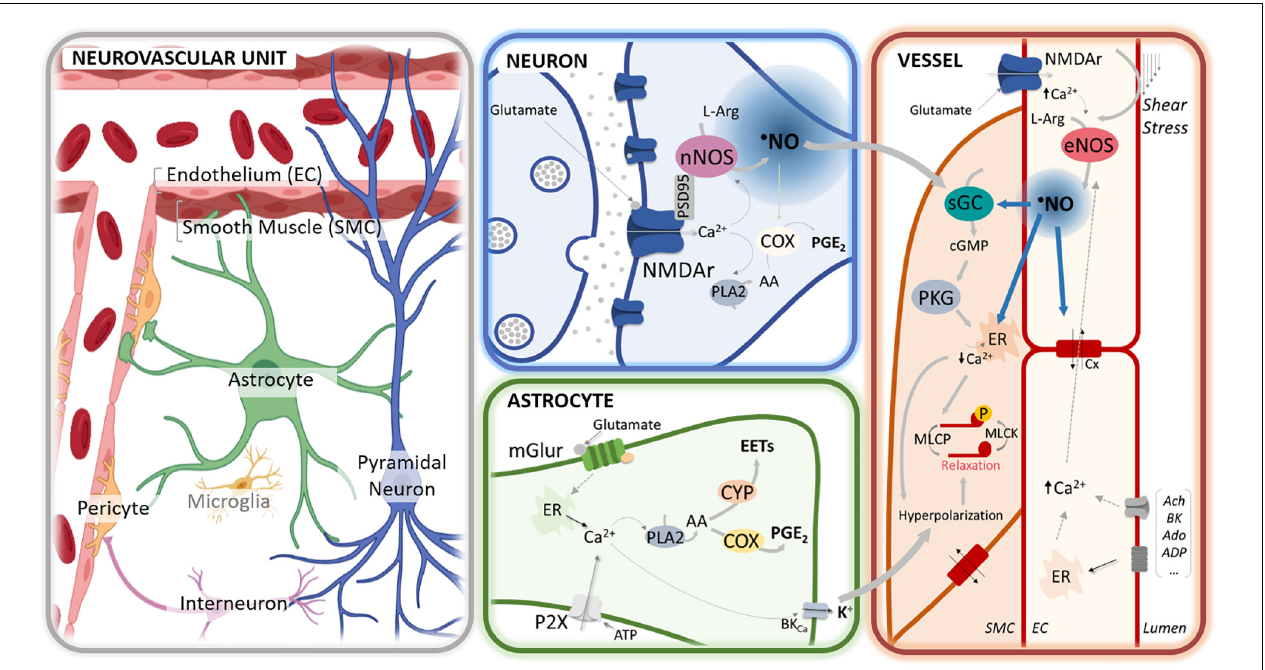
FIGURE 1 | • NO-mediated regulation of neurovascular coupling at different cellular compartments of the neurovascular unit. In neurons, glutamate release activates the N -methyl- D -aspartate (NMDA) receptors (NMDAr), leading to an influx of calcium cation (Ca 2 + ) that activates the neuronal nitric oxide synthase (nNOS), physically anchored to the receptor via the scaffold protein PSD95. The influx of Ca 2 + may further activate phospholipase A 2 (PLA 2 ), leading to the synthesis of prostaglandins (PGE) via cyclooxygenase (COX) activation. In astrocytes, the activation of mGluR by glutamate by rising Ca 2 + promotes the synthesis of PGE via COX and epoxyeicosatrienoic acids (EETs) via cytochrome P450 epoxygenase (CYP) activation and leads to the release of K + via the activation of BK Ca . At the capillary level, glutamate may additionally activate the NMDAr in the endothelial cells (EC), thereby eliciting the activation of endothelial NOS (eNOS). The endothelial-dependent nitric oxide ( • NO) production can be further elicited via shear stress or the binding of different agonists (e.g., acetylcholine, bradykinin, adenosine, ATP). Additionally, erythrocytes may contribute to • NO release (via nitrosated hemoglobin or hemoglobin-mediated nitrite reduction). At the smooth muscle cells (SMC), paracrine • NO activates the sGC to produce cGMP and activate the cGMP-dependent protein kinase (PKG). The PKG promotes a decrease of Ca 2 + [e.g., by stimulating its reuptake by sarcoplasmic/endoplasmic reticulum calcium-ATPase (SERCA)] that leads to the dephosphorylation of the myosin light chain through the associated phosphatase (MLCP) and, ultimately to vasorelaxation. Additionally, PKG triggers the efflux of K + by the large-conductance Ca 2 + -sensitive potassium channel (BK Ca ) that leads to cell hyperpolarization. Hyperpolarization is additionally triggered via the activation of the inward rectifier potassium channels (Kir) and spread rapidly to adjacent cells via gap junctions (Cx). Further, • NO can regulate vasodilation via the stimulation of SERCA, modulation of the synthesis of arachidonic acid (AA) derivatives, and regulation of potassium channels and